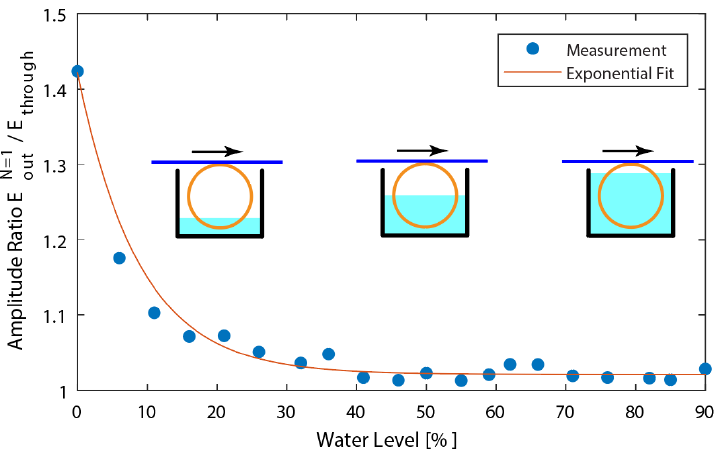
Figure 6. Normalized wave interference pattern for a standard single-mode fiber ring at water levels of 0% to 90%